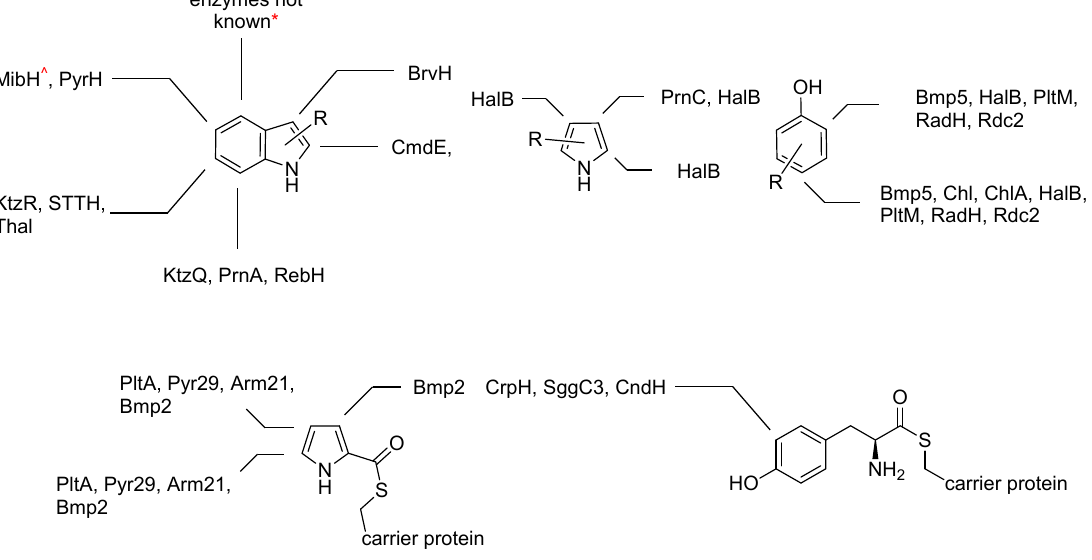
Figure 14. Regioselectivity of flavin-dependent halogenases and their dependency on carrier proteins. * Natural products with halogenations are known, but so far, no enzyme is characterized. ^ This tryptophan halogenase is one of the few examples that is carrier protein-dependent [99].